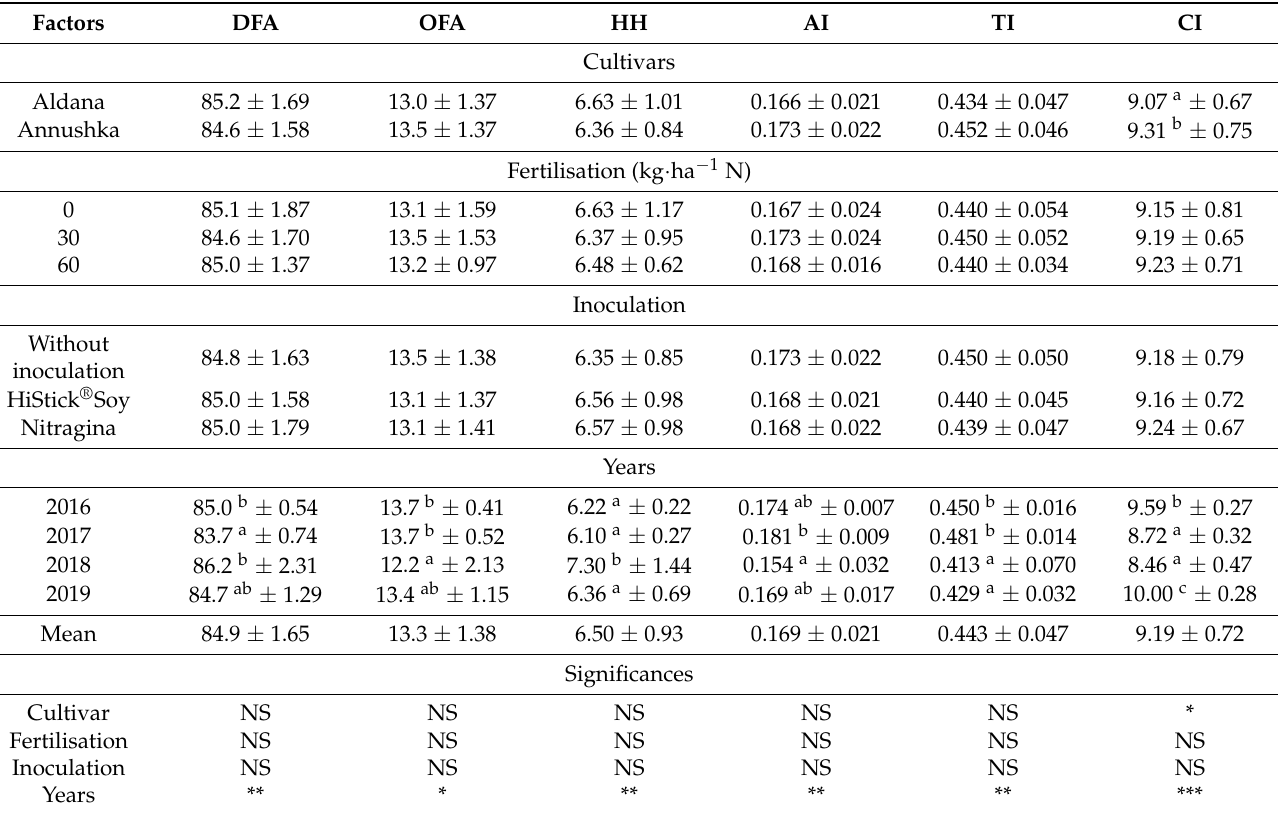
Table 5. The DFA, OFA, HH, AI, TI and CI indices of lipid quality in G. max seed; mean values for factors.